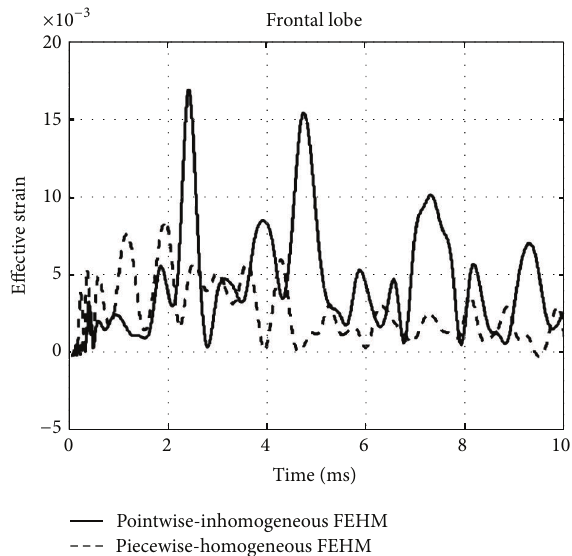
Figure 9: Effective strain at a point located in the frontal lobe.